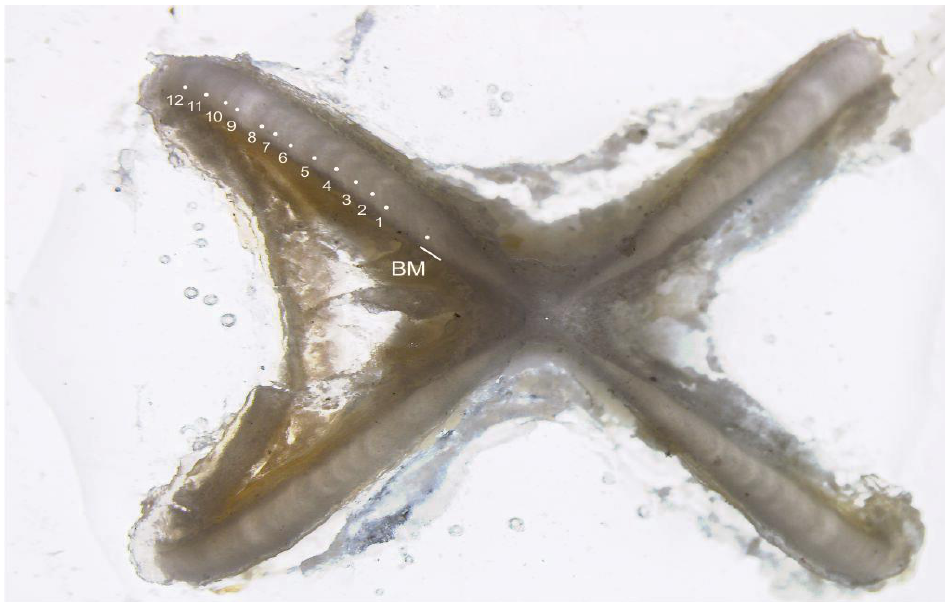
Figure 2. A vertebral cross-section of an estimated 12-year-old Dipturus oxyrinchus (total length = 93.5 cm, female) (BM, Birth Mark). White dots indicate opaque bands.